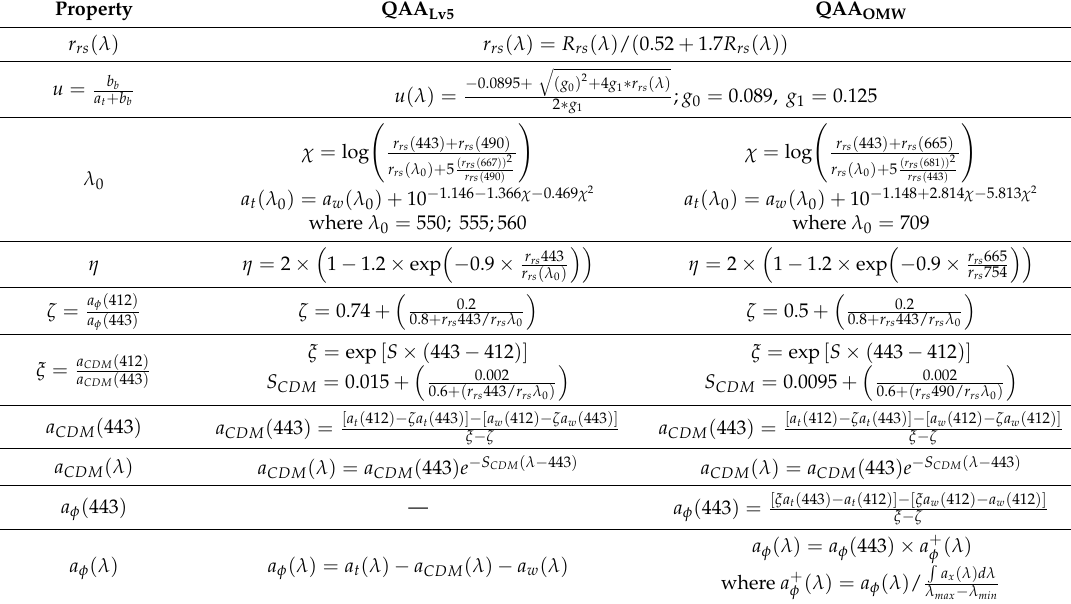
Table 2. Quasi-analytical algorithm (QAA) steps comparing version 5 from Lee et al. [20] and the QAA OMW proposed in this